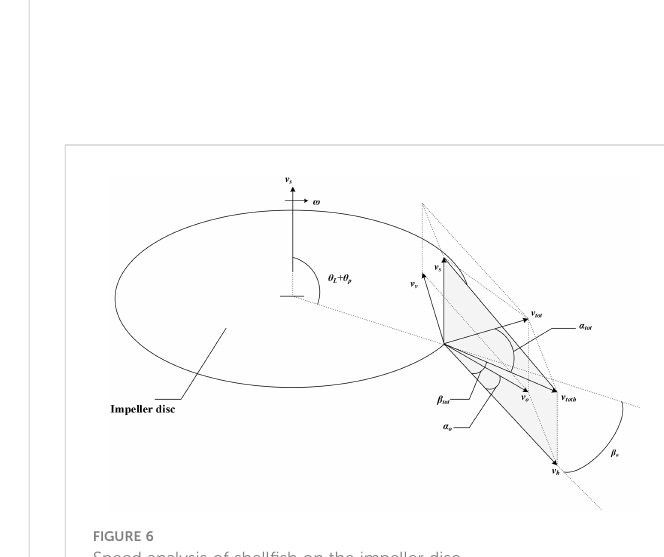
FIGURE 6 Speed analysis of shell fi sh on the impeller